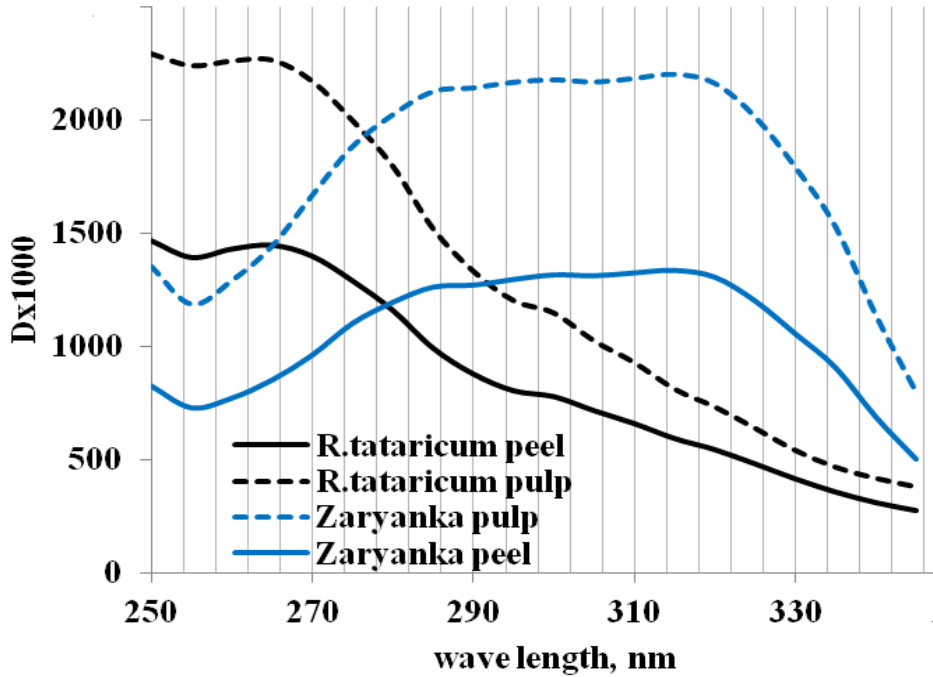
Figure 3. UV spectrum of rhubarb root peel and pulp water extracts.